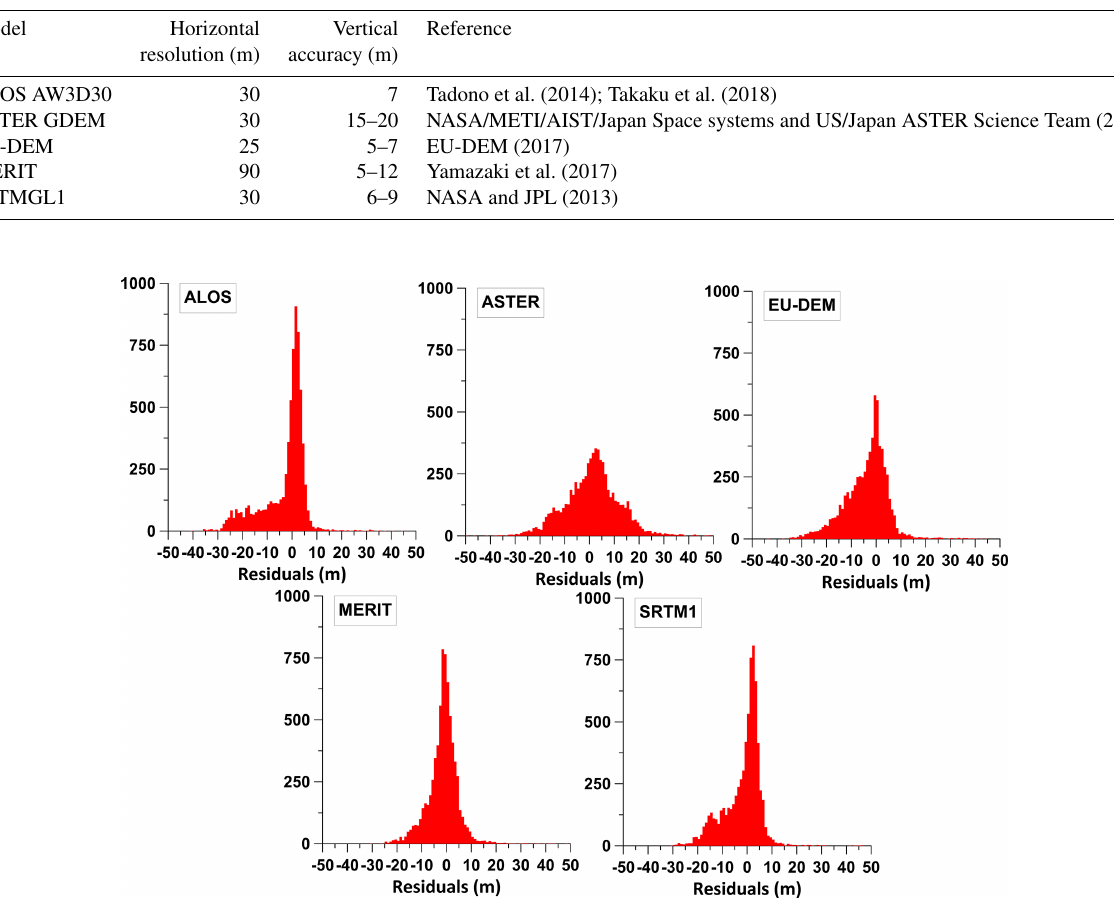
Figure C3. Histograms of height residuals between global DEMs and 7097 selected gravity stations on the territory of Slovakia. The values in the different classes are given in